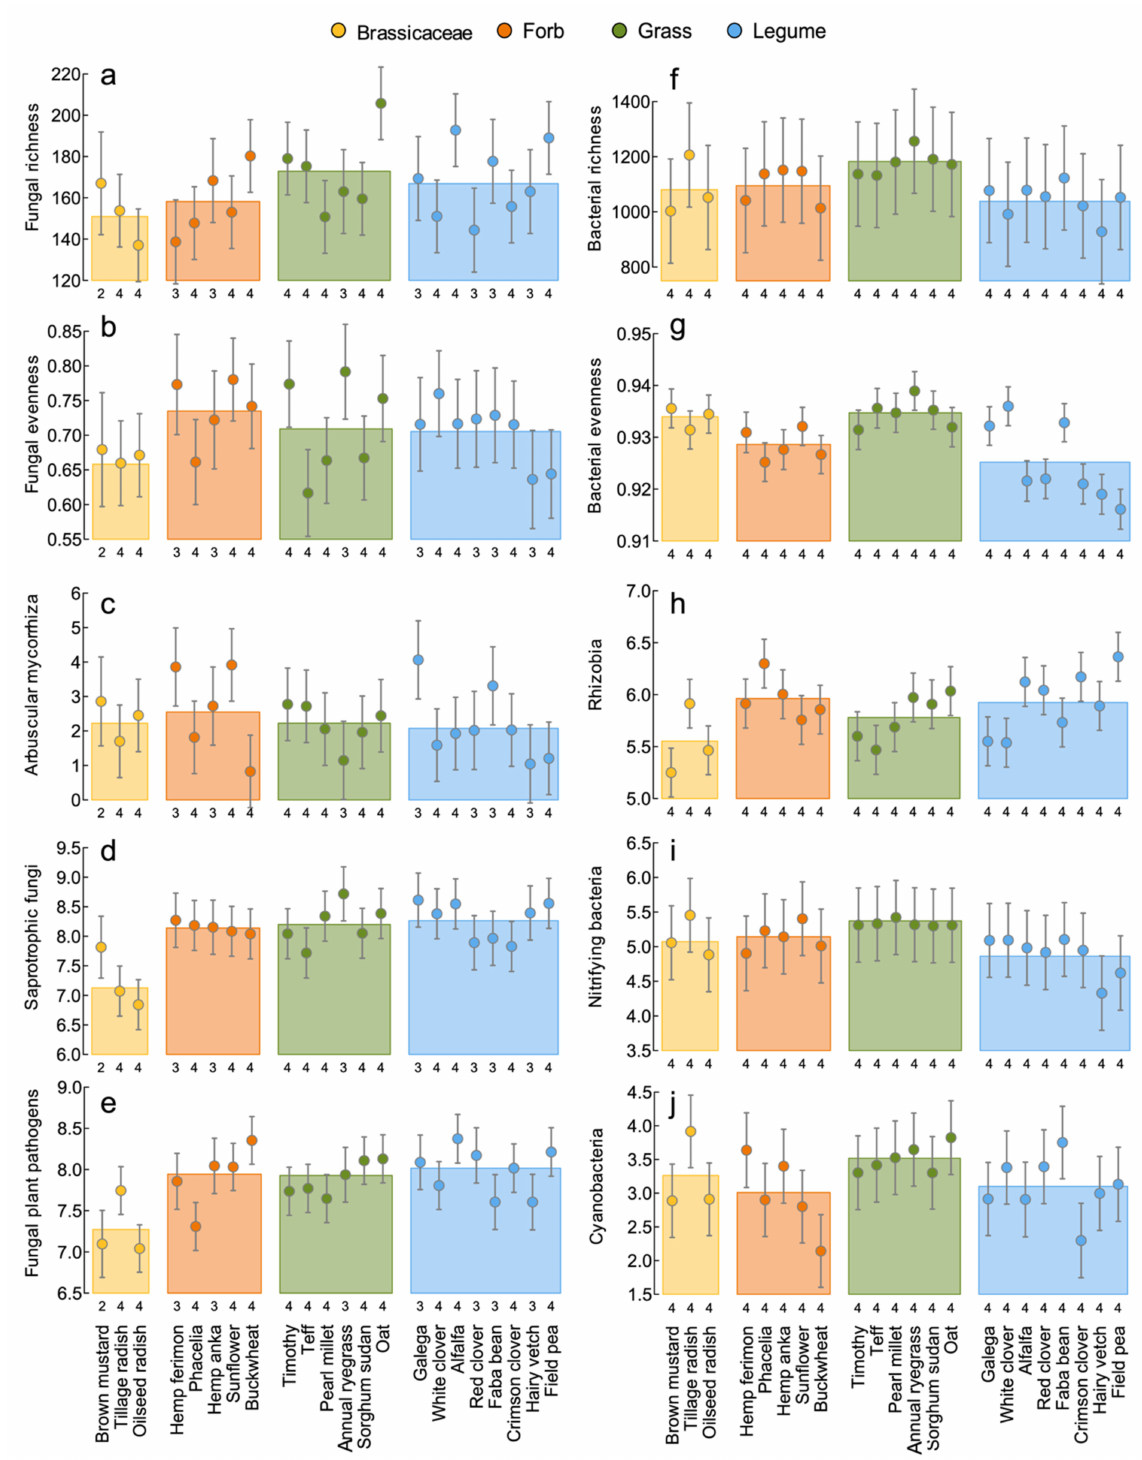
Figure 6. Soil microbial community characteristics. ( a ) Fungal richness, ( b ) Pielou’s J ’ fungal evenness, ( c ) arbuscular mycorrhizal fungi, ( d ) saprotrophic fungi, ( e ) fungal plant pathogens, ( f ) bacterial richness, ( g ) Pielou’s J ’ bacterial evenness, ( h ) rhizobia, ( i ) nitrifying bacteria and ( j ) Cyanobacteria. The abundance of key fungal ( c – e ) and bacterial ( h – i ) functional guilds are log(x + 1) transformed sequence reads. Also see Figure S1 for the variation among crops that are associated with the different microbial community